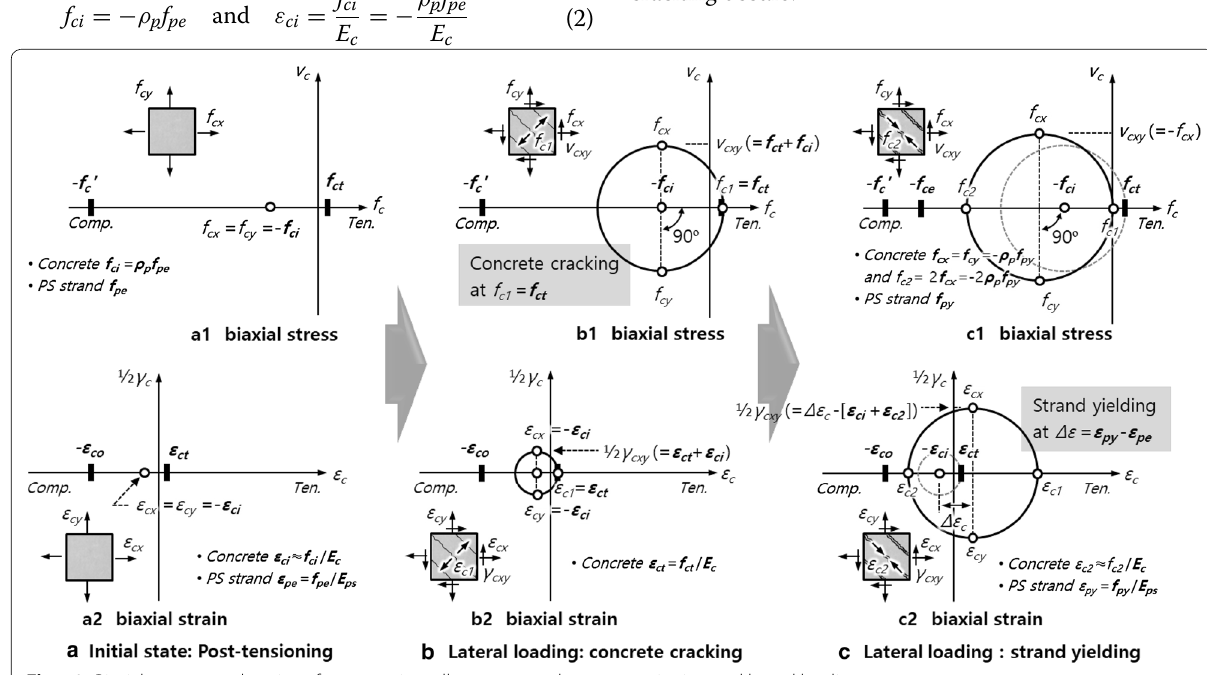
Fig. 12 Biaxial stresses and strains of concrete in wall concrete under post‑tensioning and lateral